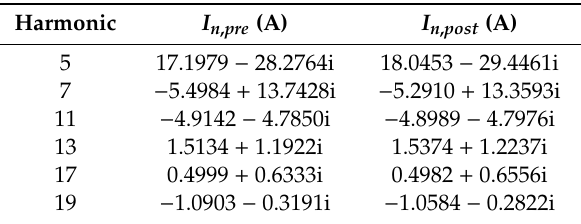
Table 5. Norton’s current injection comparison (CIC) method: Customer side impedance and magnitude of Norton’s current injection calculated using transformer charging event and calculated harmonic emission by the